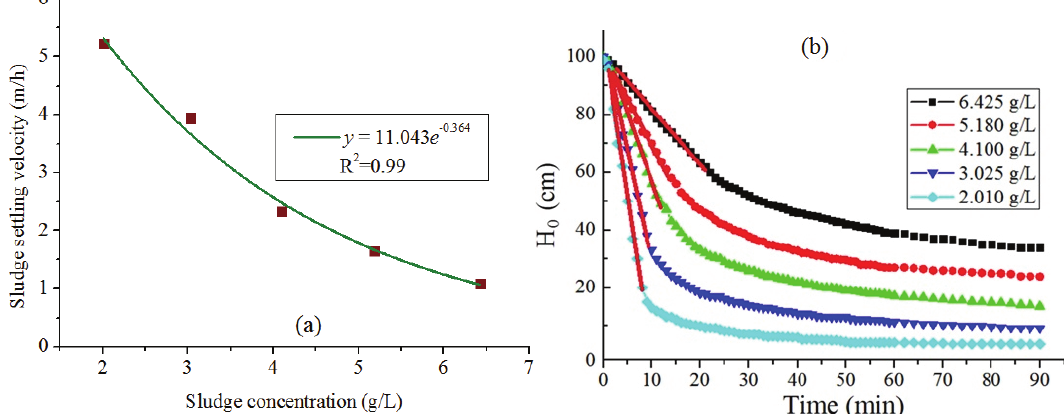
Figure 4. ( a ) Batch settling curves in wastewater treatment plant (WWTP) 5 (slope of the bold red line is the sludge hindered settling velocity at different initial sludge concentrations), ( b ) Relationship between the sludge hindered settling velocity and the corresponding initial sludge